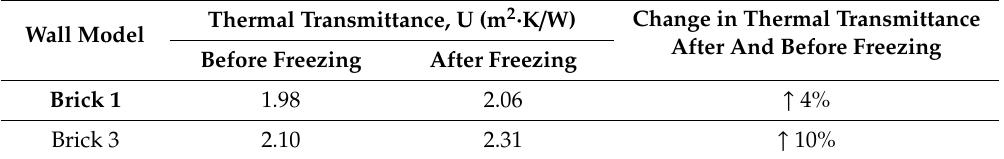
Table 7. Calculated U-value of